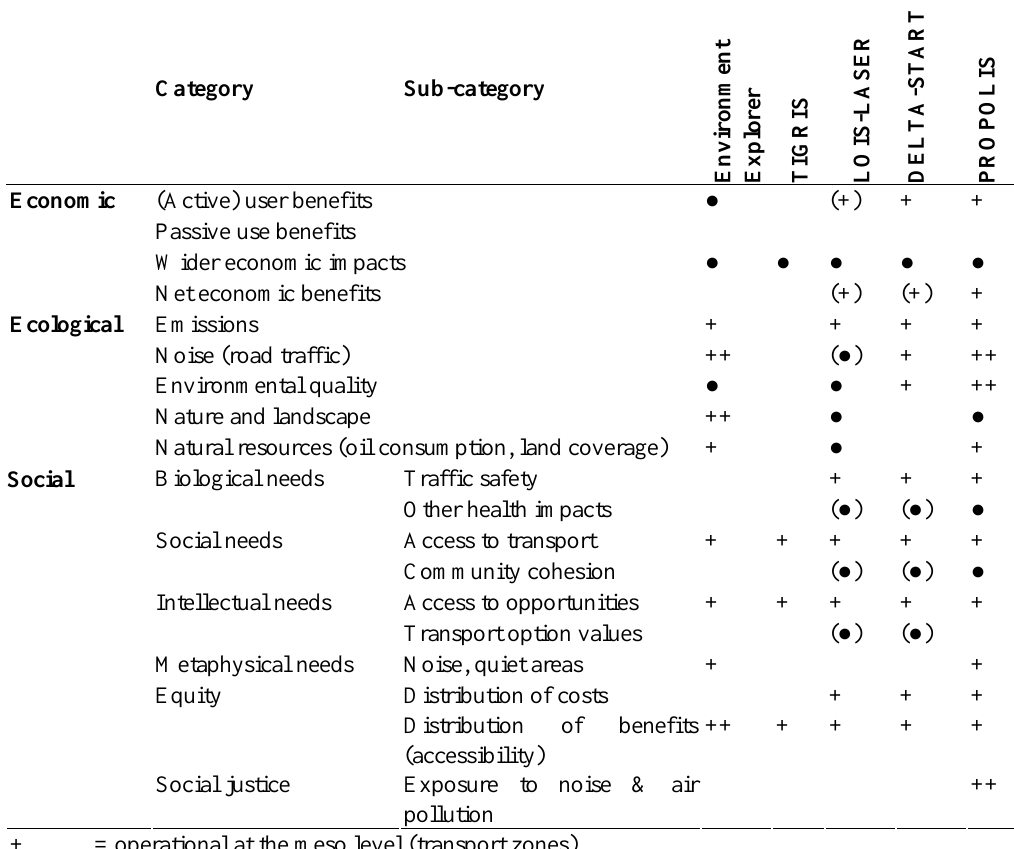
Table 3: Overview of final indicator categories in selected LUTI